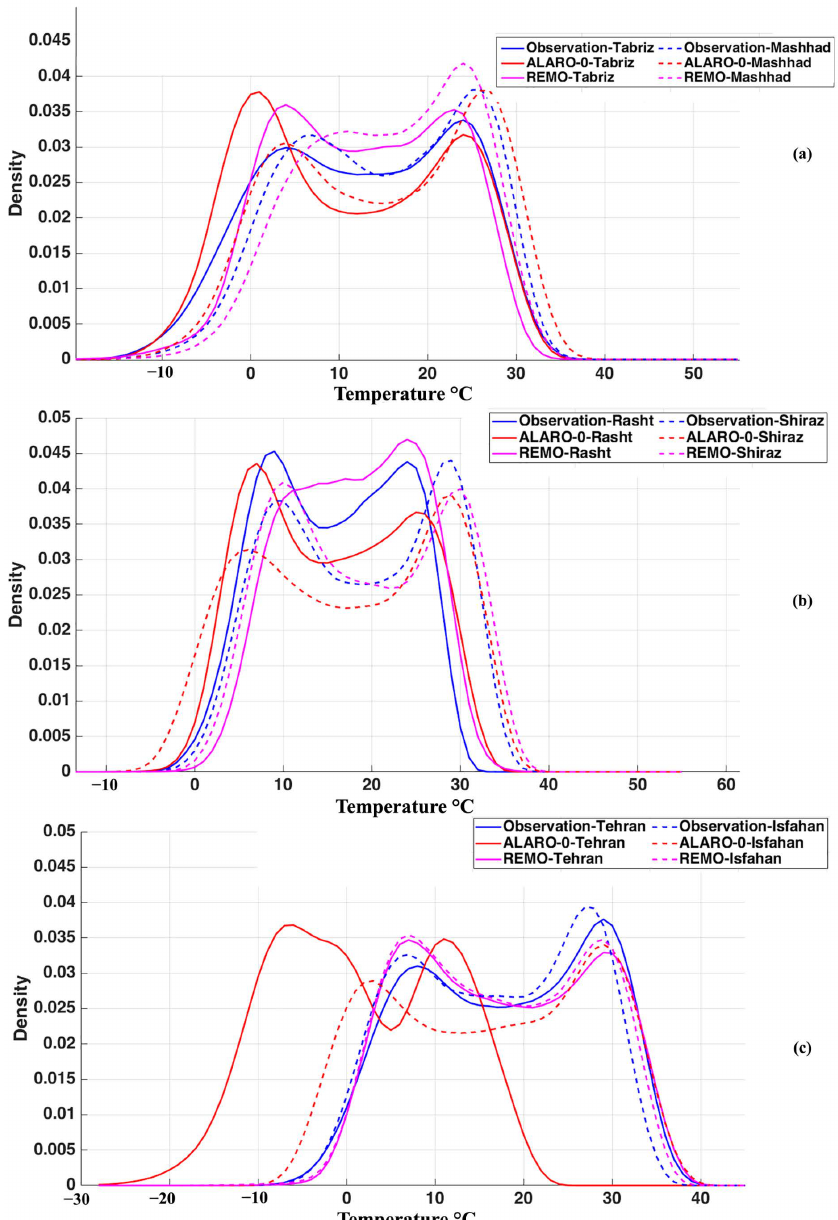
Figure 3. Probability density function plot showing distribution density for daily mean temperature comparing models with observations over the studied stations: ( a ) Tabriz and Mashhad, ( b ) Rasht and Shiraz, ( c ) Tehran and Isfahan during